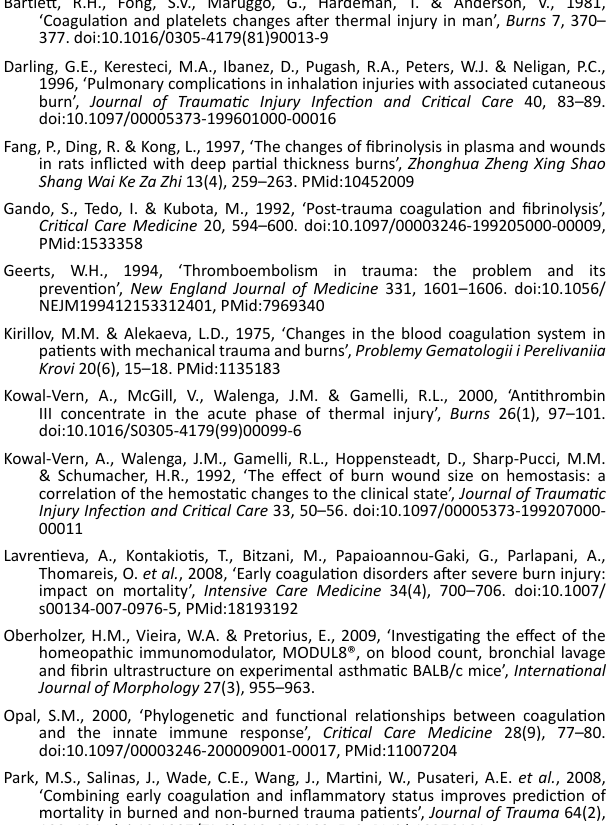
a, thick, white arrow indicates major, thick fibres; thin, white arrows indicate minor, thin fibres with netted appearance; black arrow indicates matted fibrin. b, white arrows indicate thickened, matted fibrin. c, white arrows indicate minor, thin fibres with netted appearance. FIGURE 2: Rat fibrin network after thermal injury (day 7).